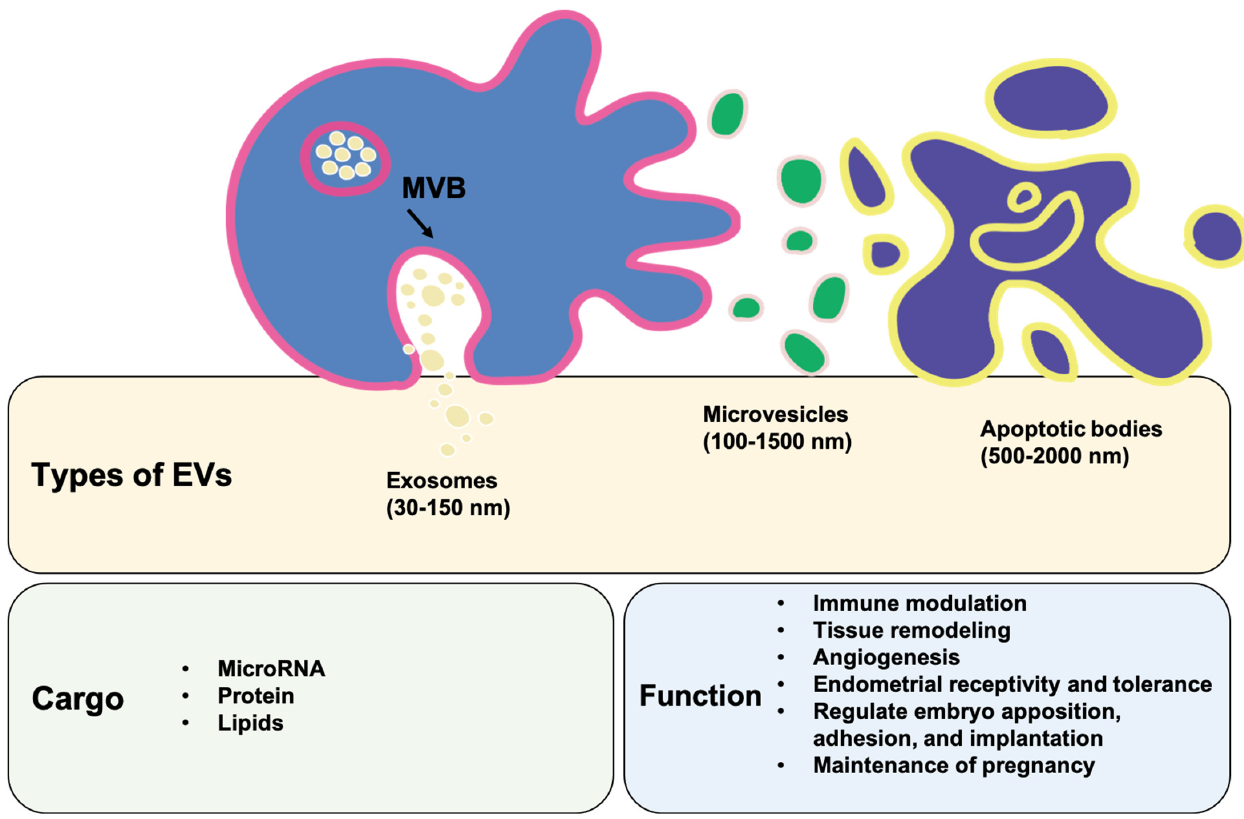
Figure 2. Characteristics, cargos, and functions of extracellular vesicles. The three main subtypes of extracellular vesicles (EVs) are exosomes, microvesicles (MVs), and apoptotic bodies, which are generally differentiated through size, content, and function examination. MVB: multivesicular body.